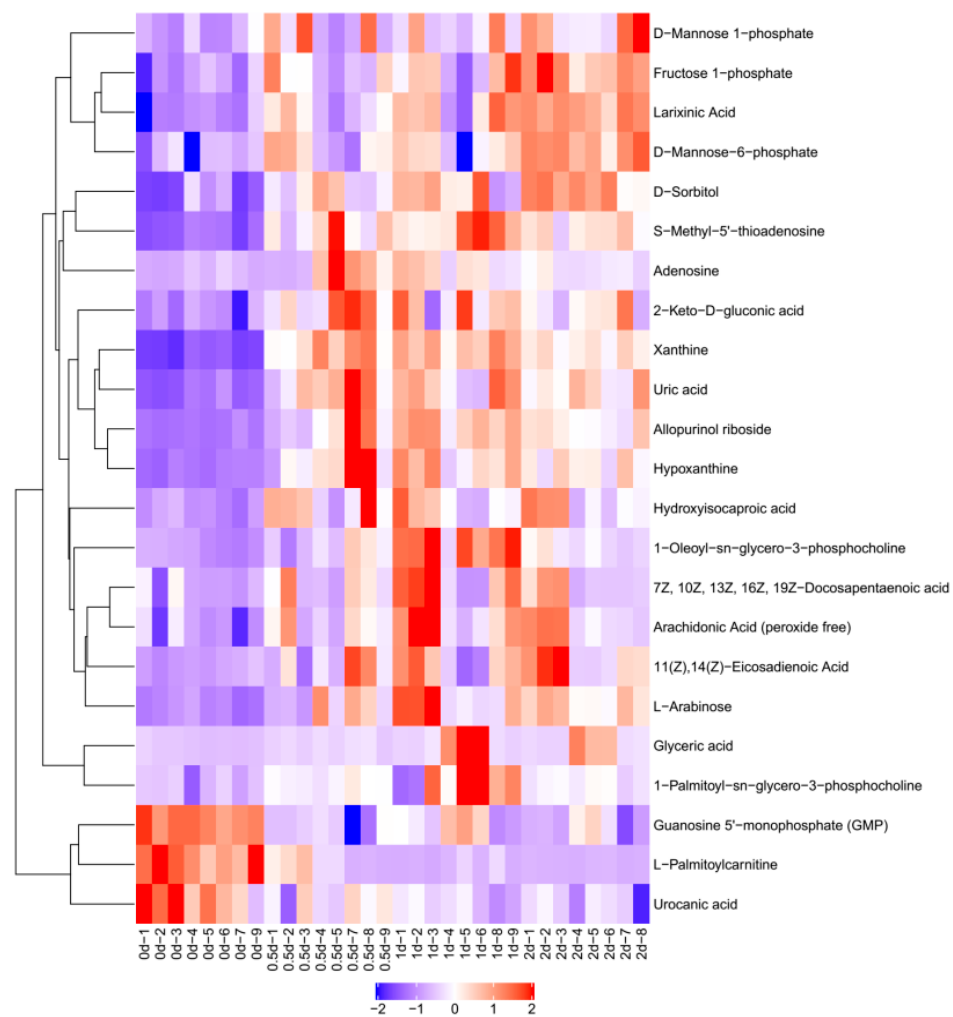
Figure 3. Hierarchical clustering analysis of differential metabolites. A hierarchical cluster analysis was conducted using R software 3.6.3. Through this software, we carried out Z-score standardization operation.